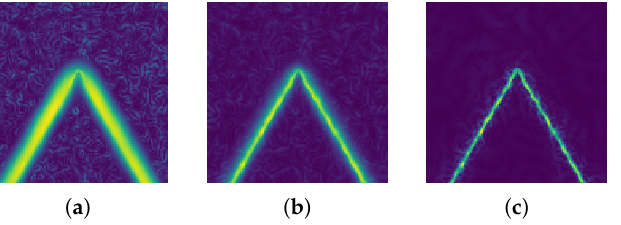
Figure 4. Impact of different strategies on W : ( a ) maximum weight strategy; ( b ) average weight strategy; ( c ) minimum weight strategy.